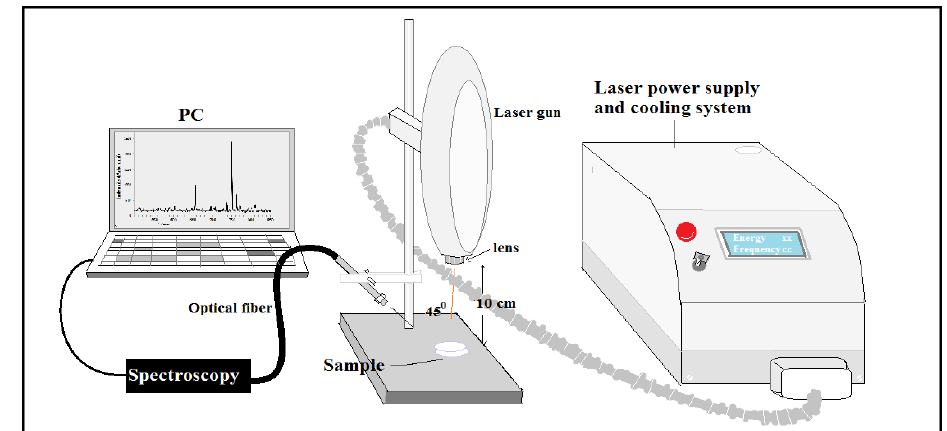
Fig. 1: Schematic of the experimental setup for the laser induced breakdown